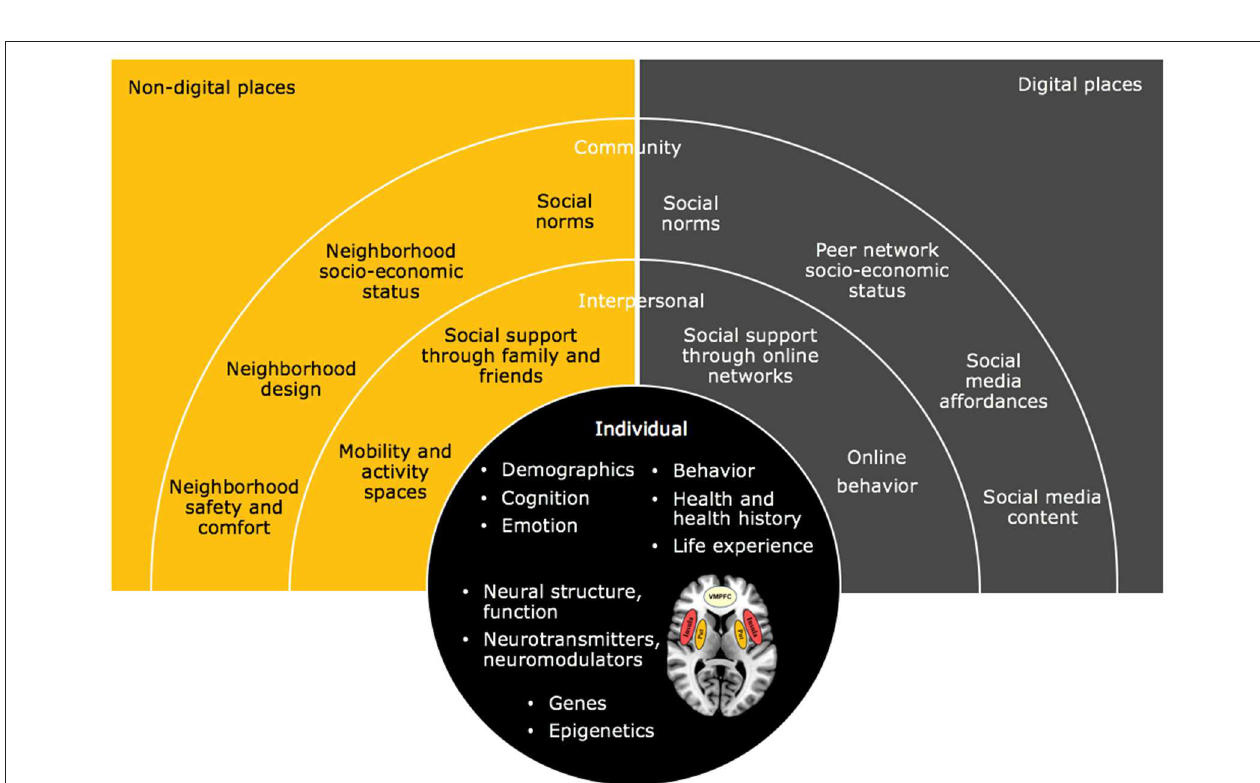
FIGURE 2 | A representation of the population neuroscience perspective for detecting suicidal thoughts using a combined approach between neuroscience and epidemiology in the context of social media based on the social ecological model (22, 64, 65). The brain areas were processed for illustrative purposes using the MRIcron software package (65) on a standard T1 model and drawn based on a recent review (43) on suicidal thoughts and behaviors. VMPFC, ventral medial prefrontal cortex; Amy, amygdala; Put, putamen.